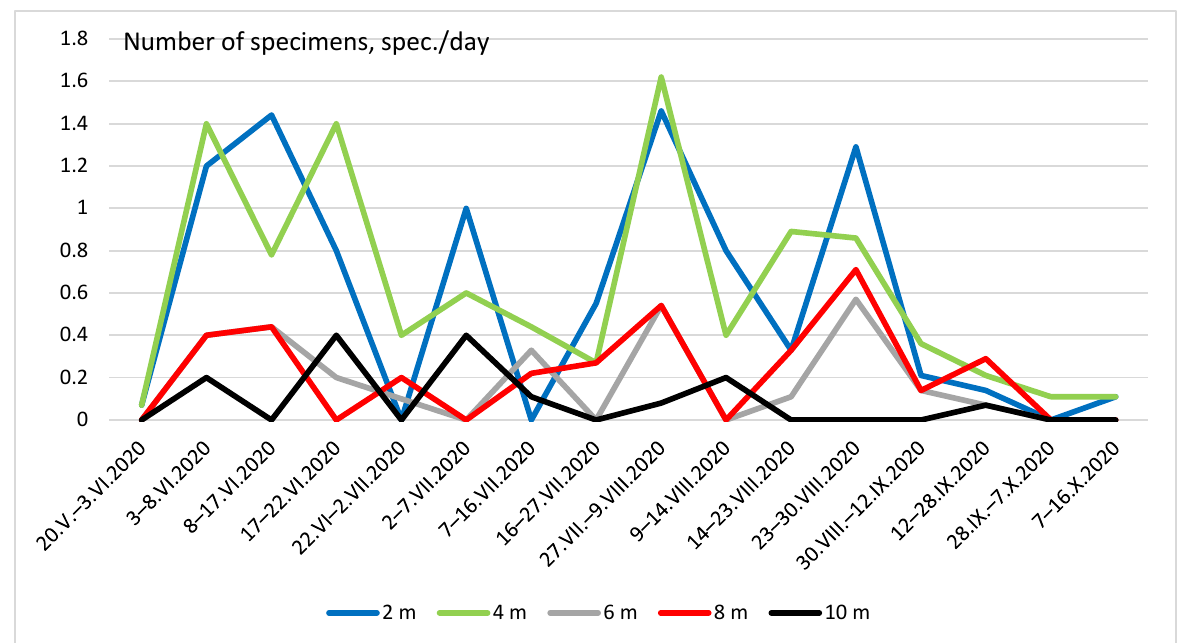
Figure 5. Seasonal dynamics of Cryptarcha strigata abundance at different heights.